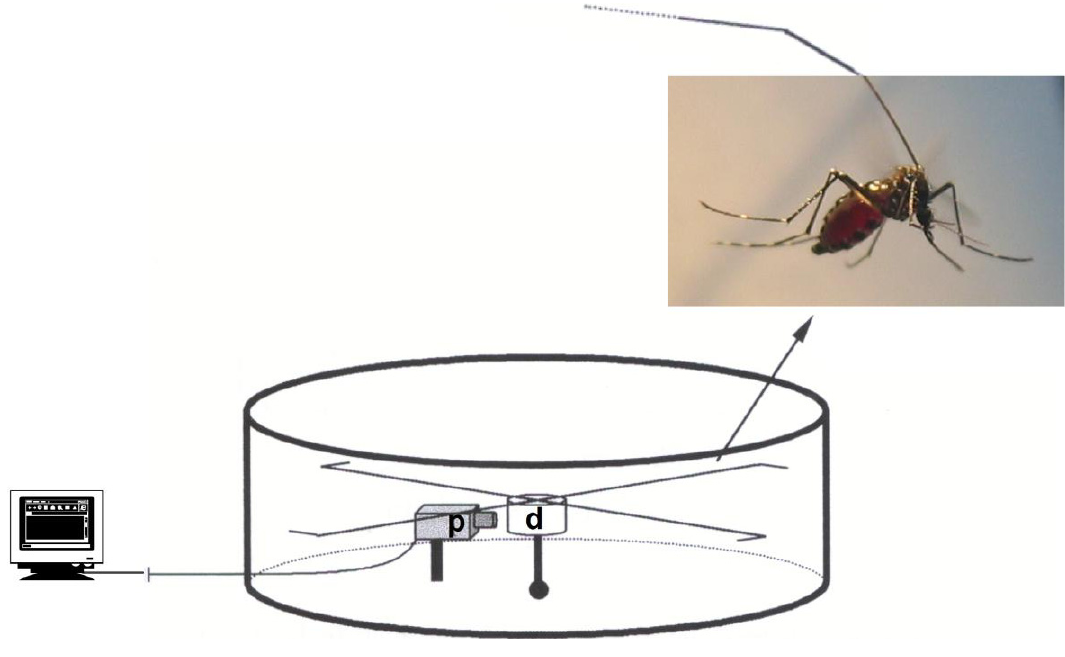
Figure 1. Flight mill (12 cm diameter × 6 cm height) with an aluminium drum (d), four arms of steel wire, and a photointerrupter (p). A female mosquito is attached to the end of one arm with wax on its scutum. The photointerrupter transmits data to a